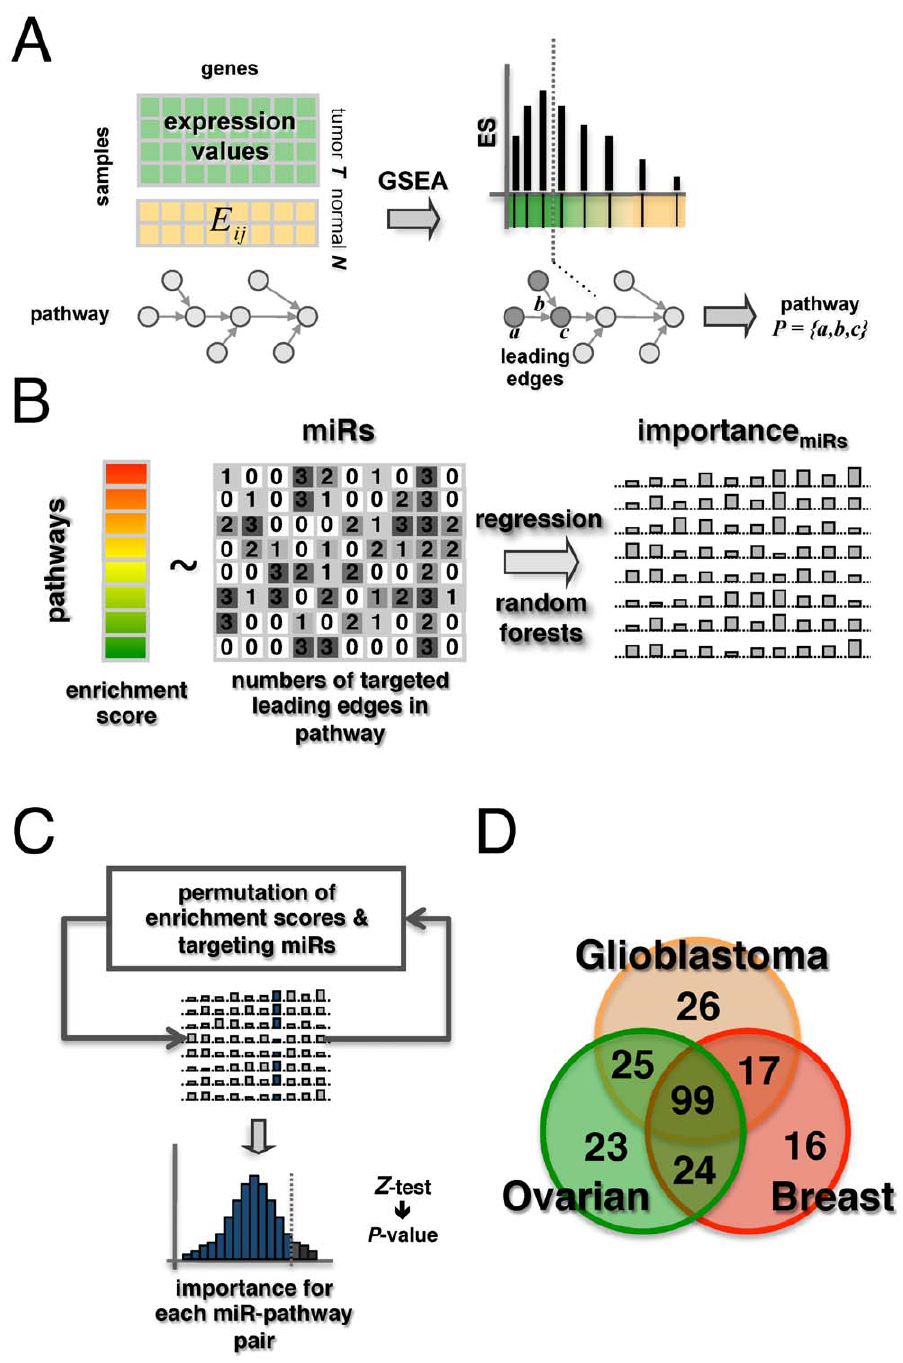
Figure 1. Prediction of important miRs. In ( A ) we utilized gene expression profiles of cancer and non-cancer control samples and determined normalized GSEA enrichment scores of molecular pathways. In addition, we represented each pathway by the corresponding set of leading edge genes (LEG). ( B ) We fitted pathway-specific enrichment scores as a function of the corresponding number of LEGs that are targeted by a given miR. Using the random forest algorithm we obtained importance scores of each miR. ( C ) To assess the statistical significance of a miR’s importance we performed permutation tests, randomizing both enrichment scores and the number of targeted LEGs. Building random distributions of importance scores, we utilized a Z-test to determine corrected P-values of each miR/pathway pair. ( D ) While we found 167 important miRs (IM) in GBMs, 171 in ovarian cancer and 156 in breast cancer (FDR , 0.01), we observed large overlaps between these sets of IMs. up-regulated pathways in ovarian cancers that largely revolved around signaling and regulation functions.